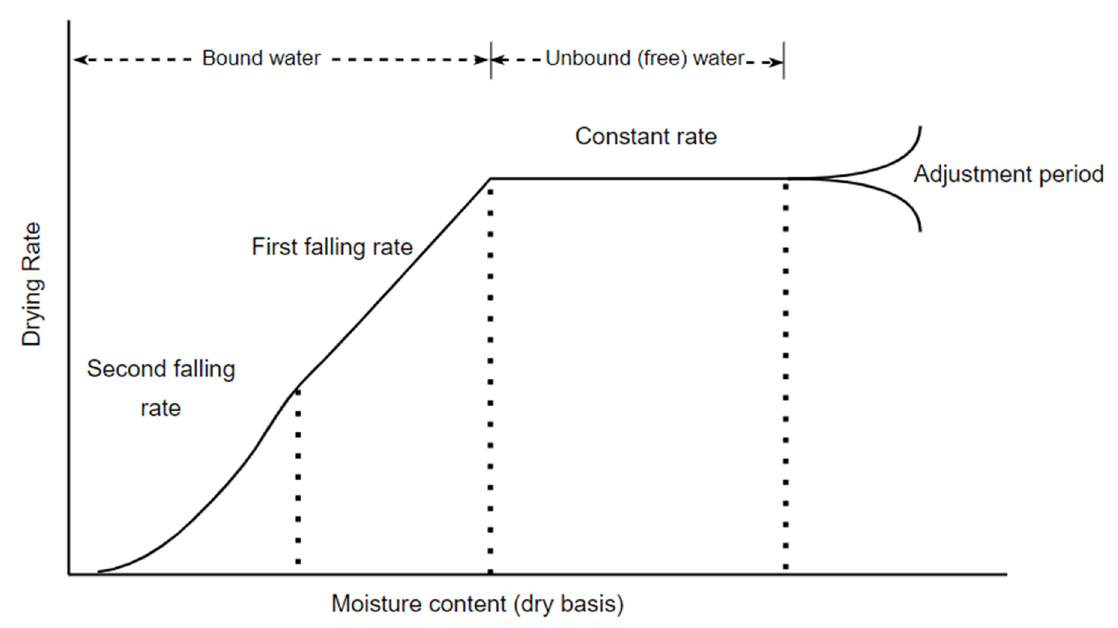
Figure 1. Typical wet solid drying curve. Table 1. Energy consumption and drying rates of biosolids dryer technologies. Adapted from